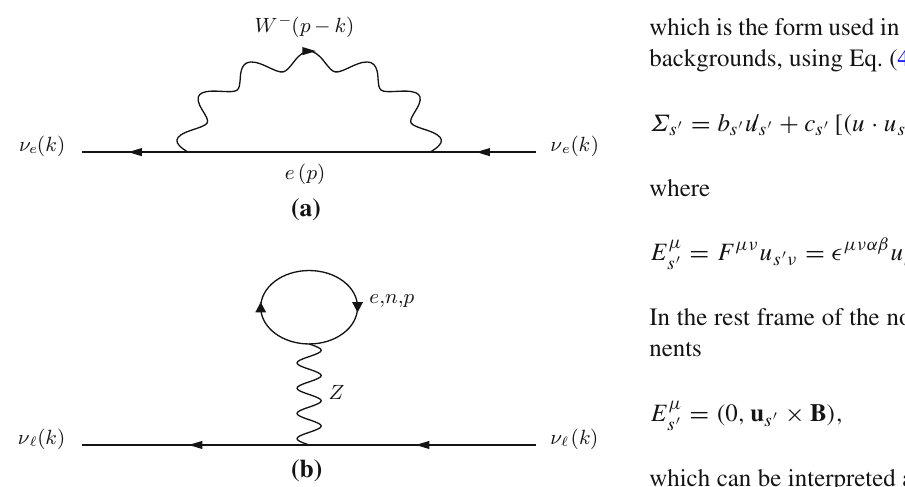
Fig. 1 The diagrams that contribute to the neutrino self-energy in a background of electrons and nucleons to the lowest order for a given neutrino flavor ν (cid:7) ((cid:7) = e ,μ,τ) . Diagram a contributes only to the ν e self-energy, while Diagram b contributes for the three neutrino flavors. In our calculation we consider two sets of these two diagrams, one set with the normal background ( s = e , n , p ) and another set with the stream backgrounds ( s (cid:3) = e (cid:3) , n (cid:3) , p (cid:3)